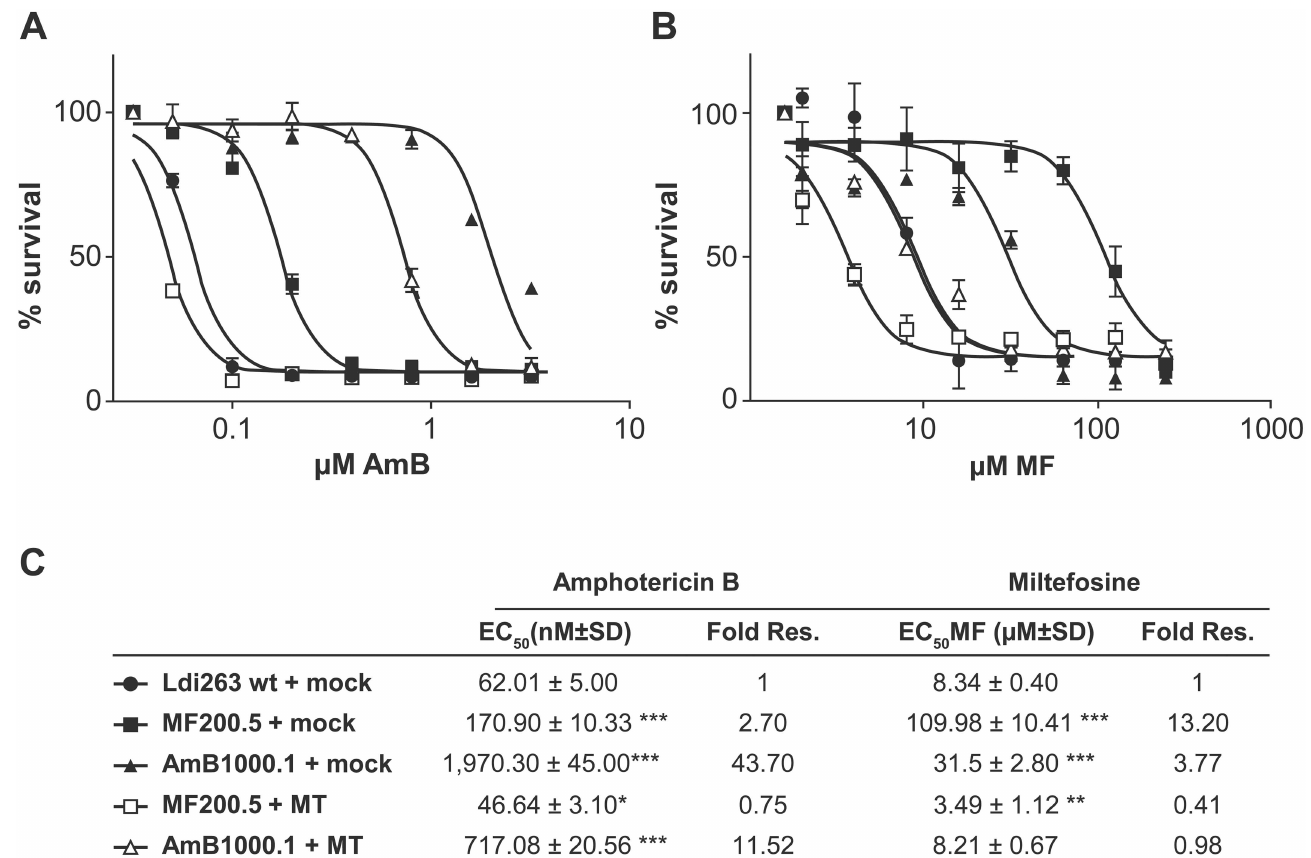
Fig 1. Role of mutations in the miltefosine transporter(MT) in miltefosine and amphotericin B cross-resistance. Dose-response curves with promastigotes in the presenceof AmB (A) and MF (B) for Ldi263wt ( ● ); MF200.5 ( ■ ); AmB1000.1( ▲ ) mock-transfected parasites; MF200.5+MT ( □ ); and AmB1000.1+MT ( 4 ) add-backcell lines over 72 h. An averageof at least three independentbiological replicates is shown, with error bars depictingthe standarderror of the mean. EC 50 values were calculatedfrom the dose-responsecurves after performinga nonlinearfitting with the Graphpad5.0 software program (C) . Statistical significance betweenthe mock-transfected wild-typeand the rest of the strains was evaluatedby unpairedtwo-tailed t-test ( * p (cid:20) 0 . 05 , ** p (cid:20) 0 . 01 , *** p (cid:20) 0 . 001 ).